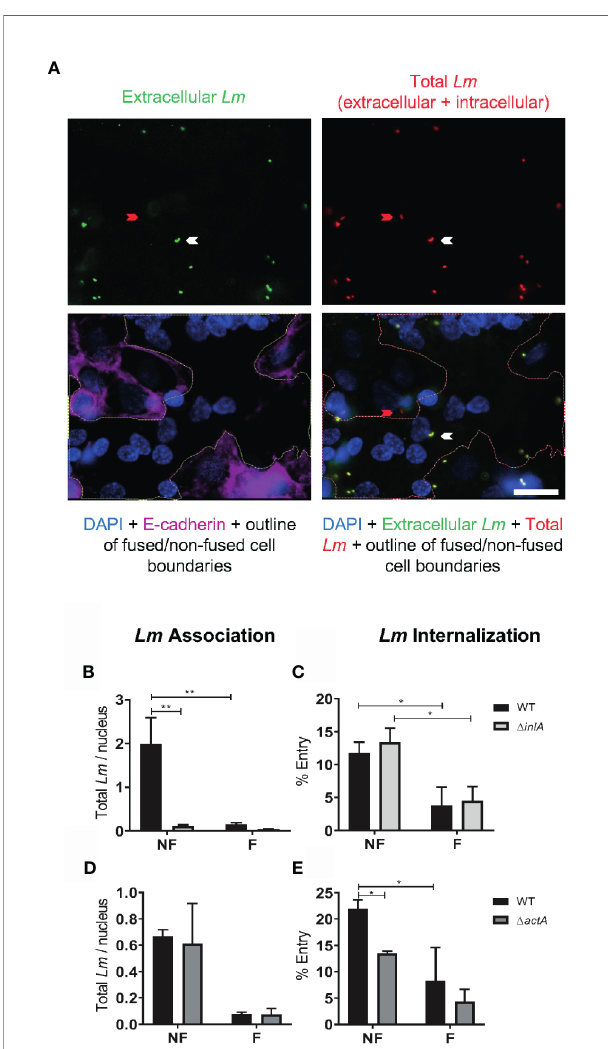
FIGURE 2 | L. monocytogenes association and internalization into primary human trophoblasts. PHT were infected with isogenic L. monocytogenes ( Lm ) WT, D inlA , or D actA at MOI 1 (A – C) or 0.5 (D, E) for 1 h at 37°C. Cells were washed, fi xed and labeled to enumerate bacterial association and internalization into fused (F) and non-fused (NF) trophoblasts by fl uorescence microscopy. Ten fi elds of phase-contrast and fl uorescence images (DAPI, total Lm -Alexa Fluor 488, extracellular Lm -Alexa Fluor 568, and E-cadherin-Alexa Fluor 647) were randomly acquired from duplicate slides (20 image sets), for each experimental condition using a 100X objective. (A) Representative images. The red arrow points towards an intracellular Lm within a non-fused trophoblast. The white arrow points towards an extracellular Lm on a fused cell. A white outline was drawn on the overlay images to delineate the boundaries between non-fused and fused trophoblasts. Scale bar = 20 µm. (B – E) The numbers of total Lm (Nt), extracellular Lm (Ne), and DAPI-labeled host cell nuclei (Nn) were counted in fused and non-fused PHT. Lm Association (B, D) was calculated as Nt/Nn. Lm Internalization (C, E) was calculated as [(Nt – Ne)/Nt] x 100. Data are expressed as the average ± SEM ( B, C n = 5) of 3 independent experiments (3 placentas) ( D, E n = 3). Statistical signi fi cance was determined by 2-way ANOVA. P-values were adjusted using Holm-Sidak ’ s multiple comparisons test, **P = 0.0024, *P = 0.0266 (B, C) ; *P = 0.0304, 0.0486 (E) . All cell counts corresponding to data analysis of Figure 2 are summarized in Figure S9